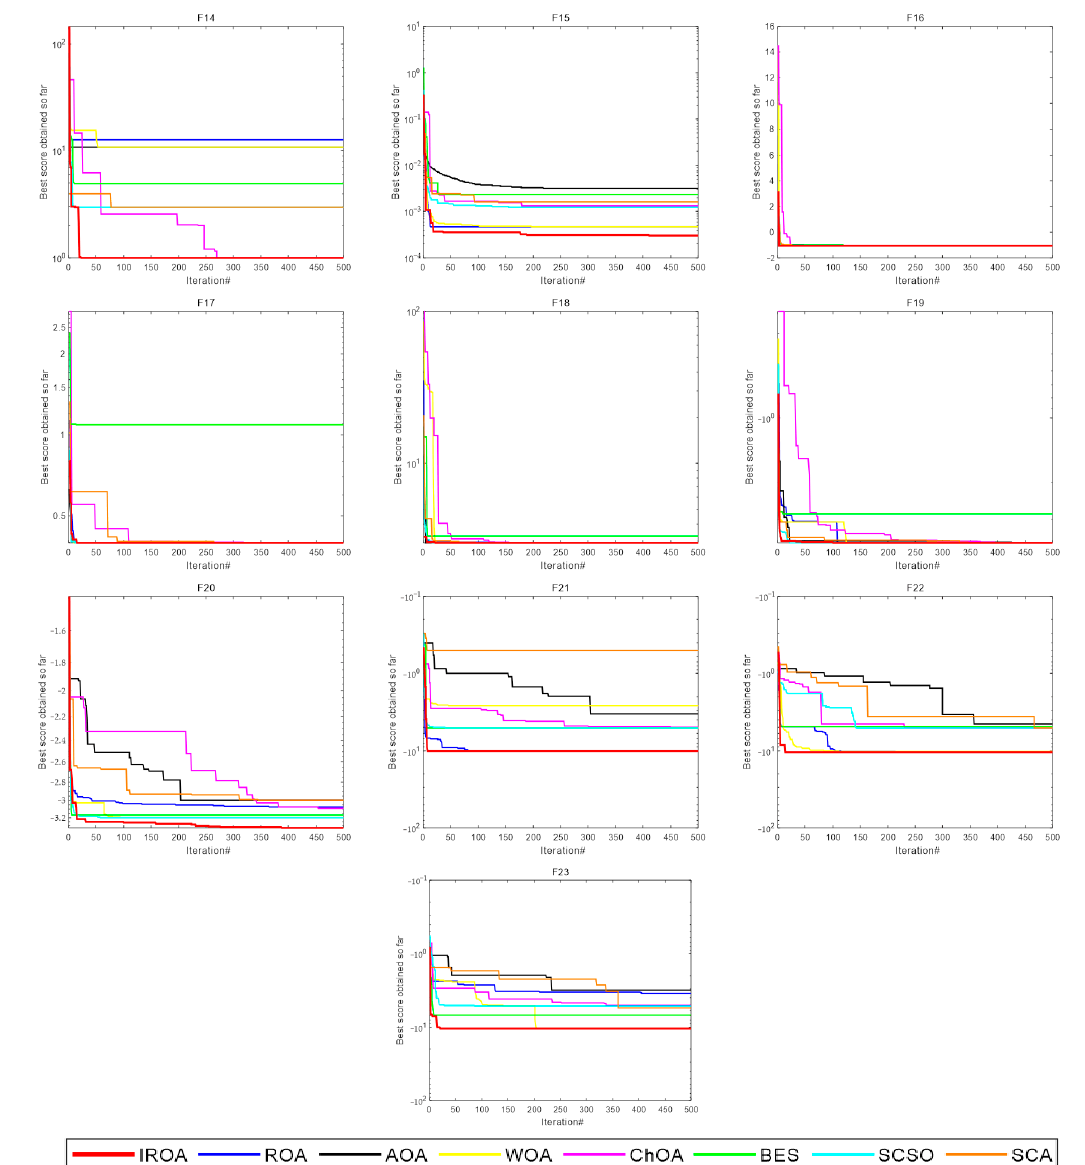
Figure 6. Convergence curves of each algorithm for standard benchmark functions ( F14 – F23 ).